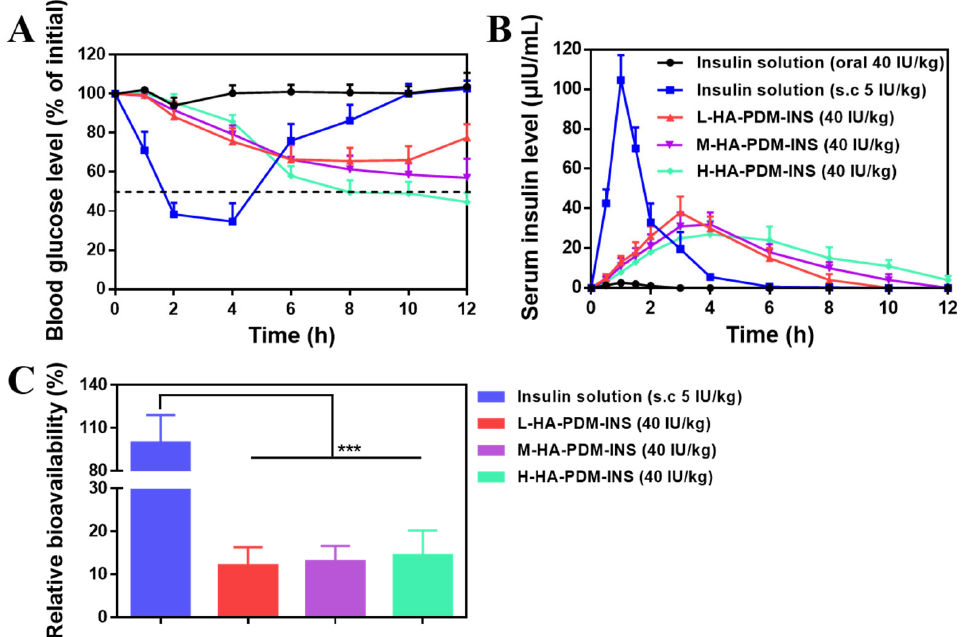
Figure 8. ( A ) Blood glucose level vs. time profiles of the diabetic rats following the administration of different formulations (X ± SD, n = 6). ( B ) Serum insulin level vs. time profiles of diabetic rats following the administration of different formulations (X ± SD, n = 6). ( C ) Relative bioavailability (X ± SD, n = 6, *** p < 0.001).